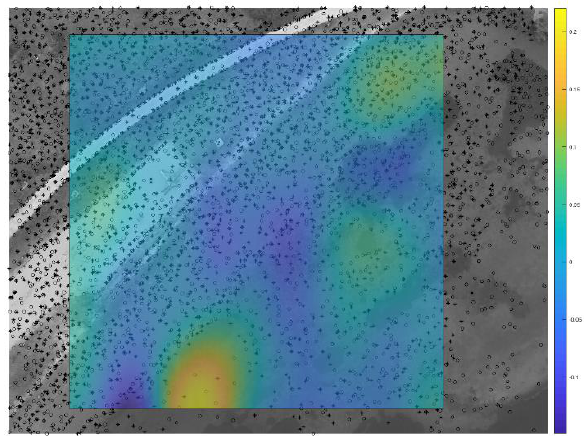
Figure 6. Analysis of relative precision based on height differences (in [m]) of overlapping DEM’s from stereo pairs - 2915/2951 (stars) and 3088/3093